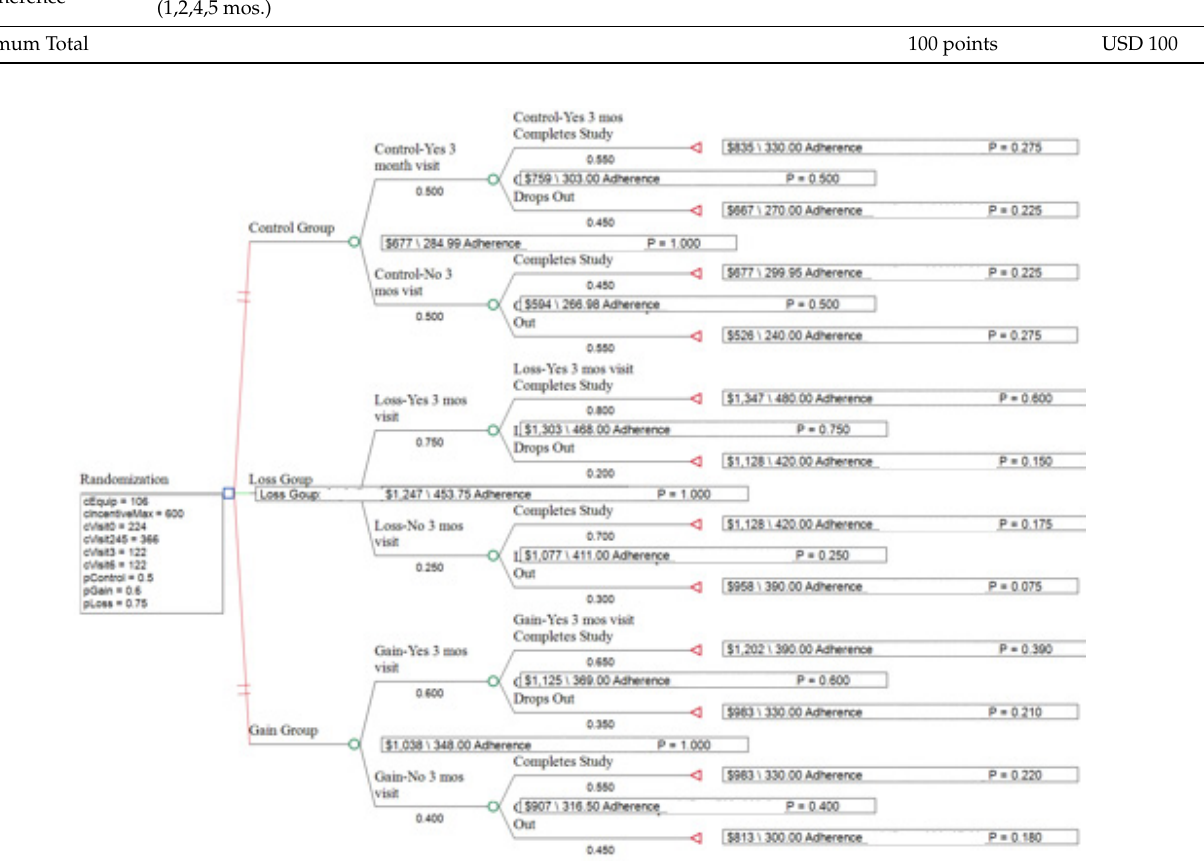
Figure 1. The TreeAge Diagram of the Study Strategies. Branches represent group randomization, the likelihood to keep the 3-month visit, and then completing study. Each branch has cost, adherence, and predicted probability.